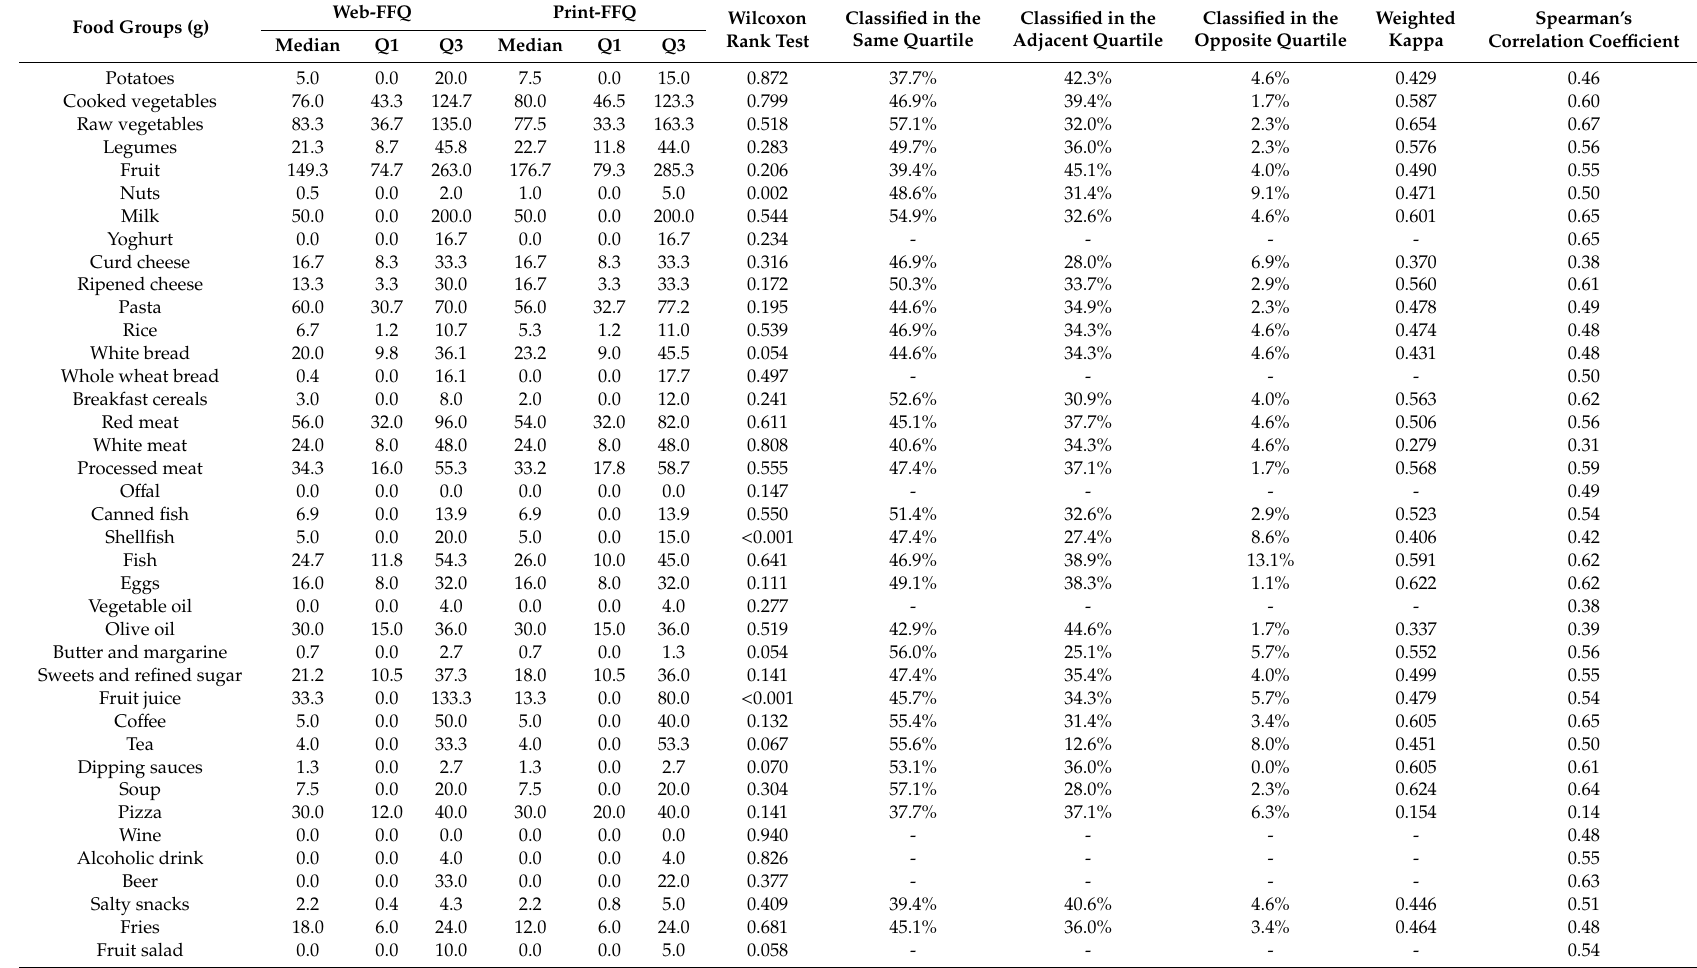
Table 1. Daily food intakes, Spearman’s correlation coe ffi cients and quartile misclassification analysis between the web-FFQ and